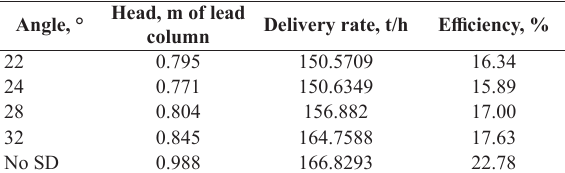
Figure 2. Pump head and delivery rate as a function of the SD inlet flow angle with an invariable pump shaft speed of n = 1000 rev/min. Table 1. Pump performance with n = 1000 rev/min.